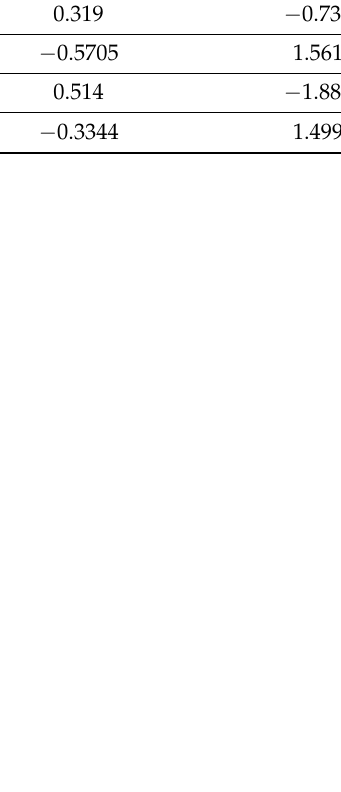
Figure 6. Geometry of the specimens tested in the program. R = 1.0 ( a ), R = 2.5 ( b ), R = 5.0 ( c ), R = 10.0 ( d ), smooth round ( e